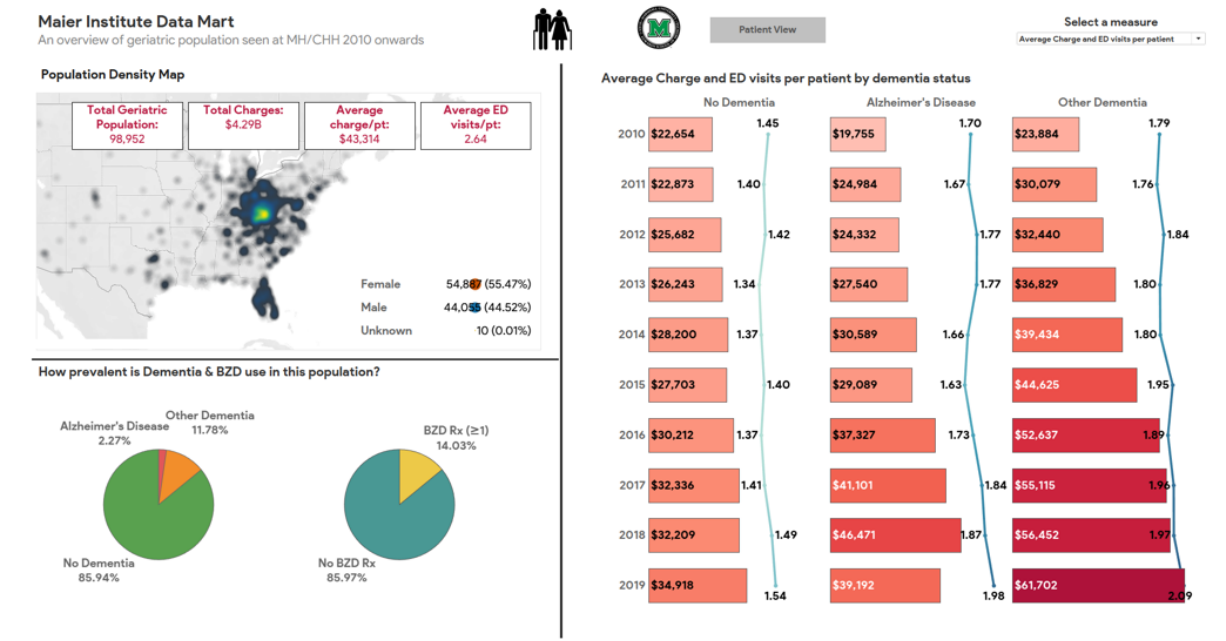
Figure 2. Tableau dashboard displaying key information on the geriatric population, including heat map, dementia prevalence, benzodiazepine use,